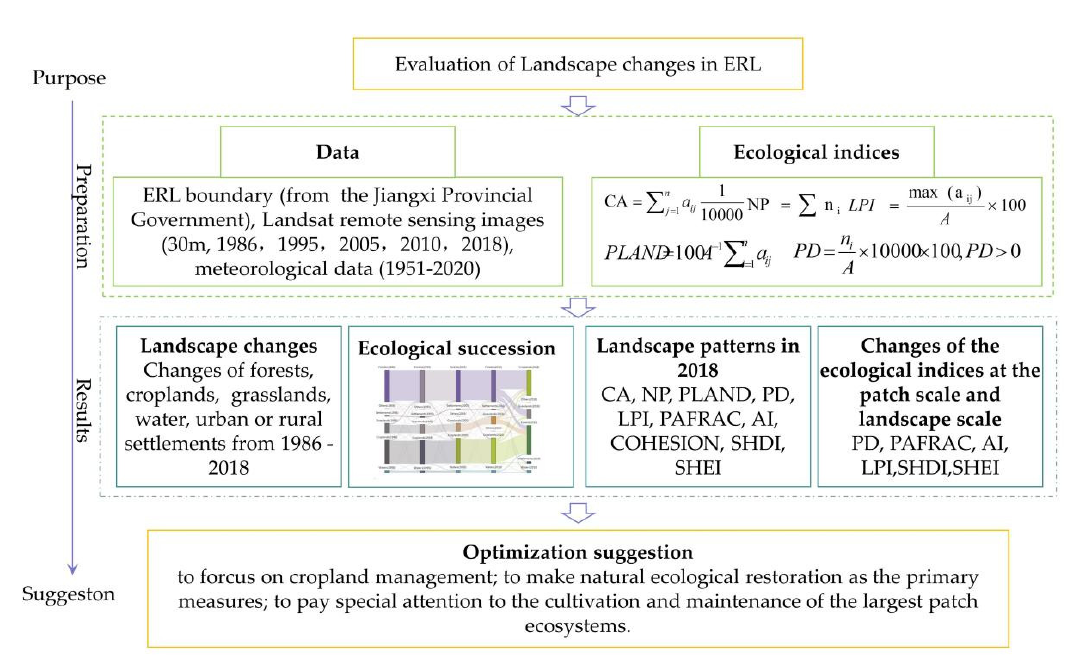
Figure 3. The framework for landscape changes and optimization in ERLS in the UR-GJ.